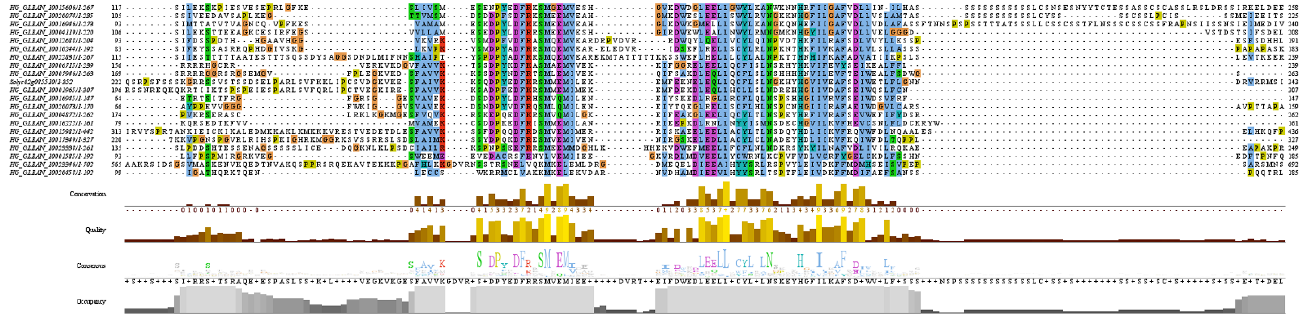
Figure 2. Sequence alignment of OVATE homologous proteins between bottle gourd and tomato.